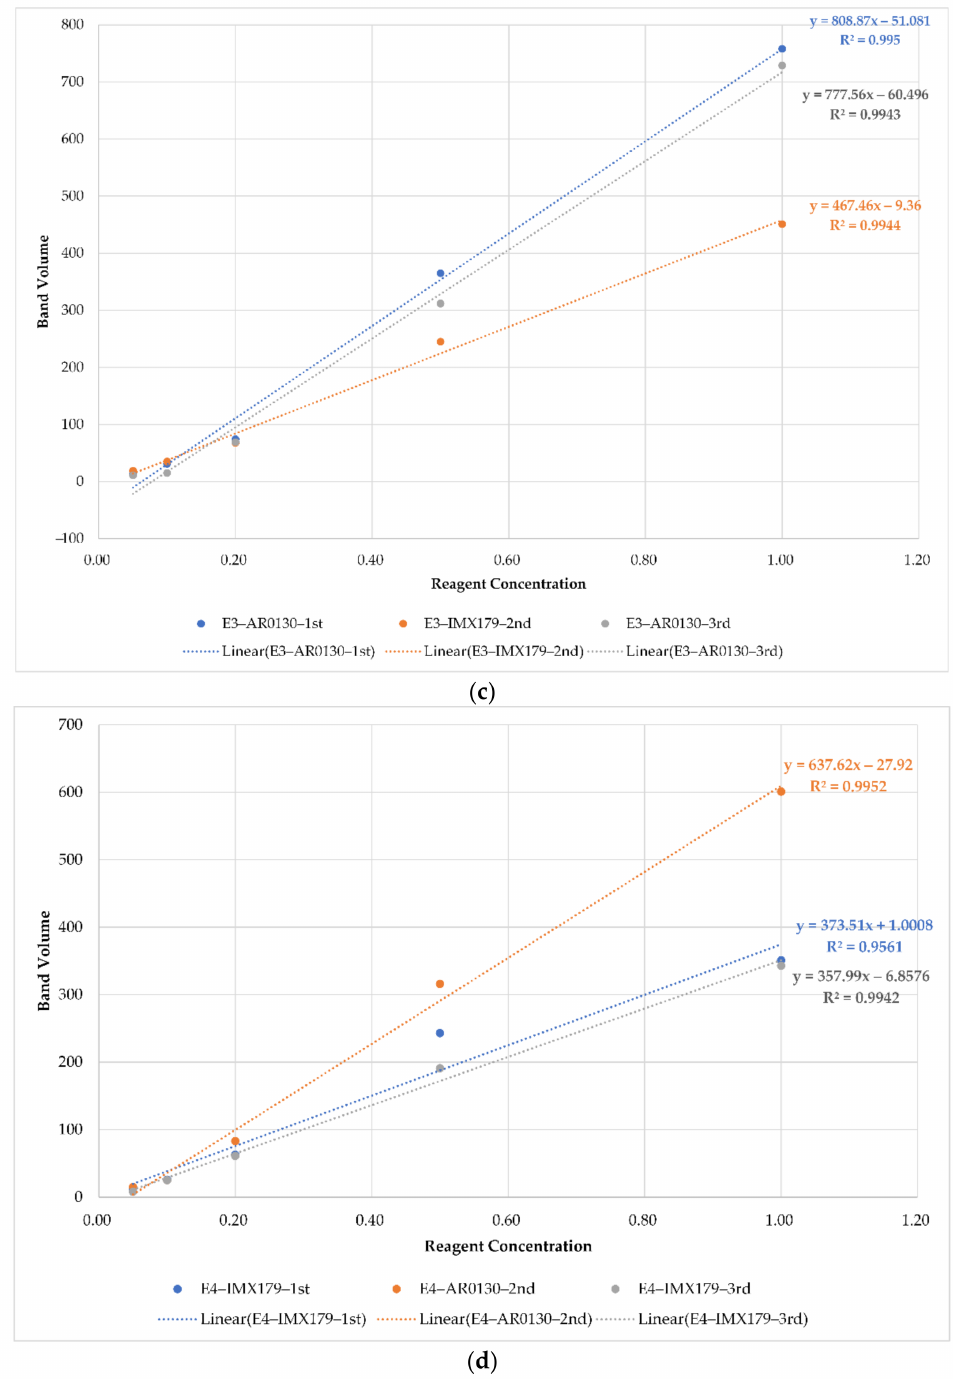
Figure 10. Band image analysis: ( a ) exp #1; ( b ) exp #2; ( c ) exp #3; ( d ) exp